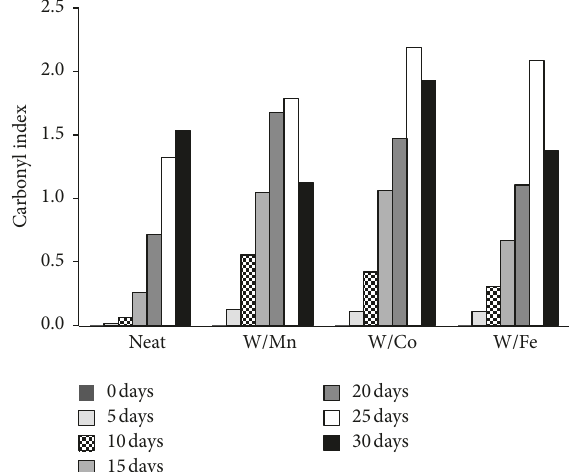
Figure 5: Increase in the carbonyl index of Topas 6013 COC neat and formulated films during exposure to QUV irradiation.